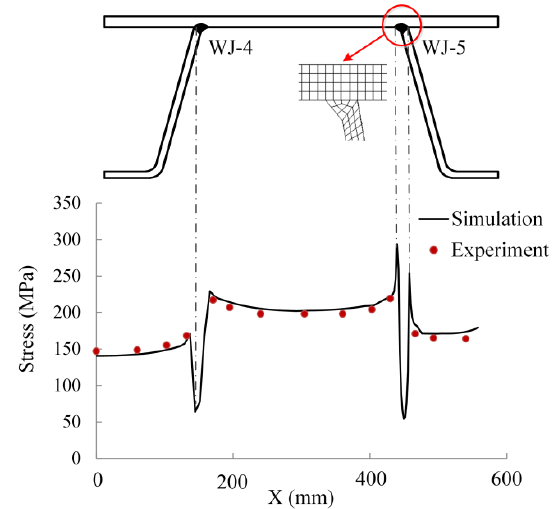
Figure 11. Comparison of the numerical simulation results with the experiment results.